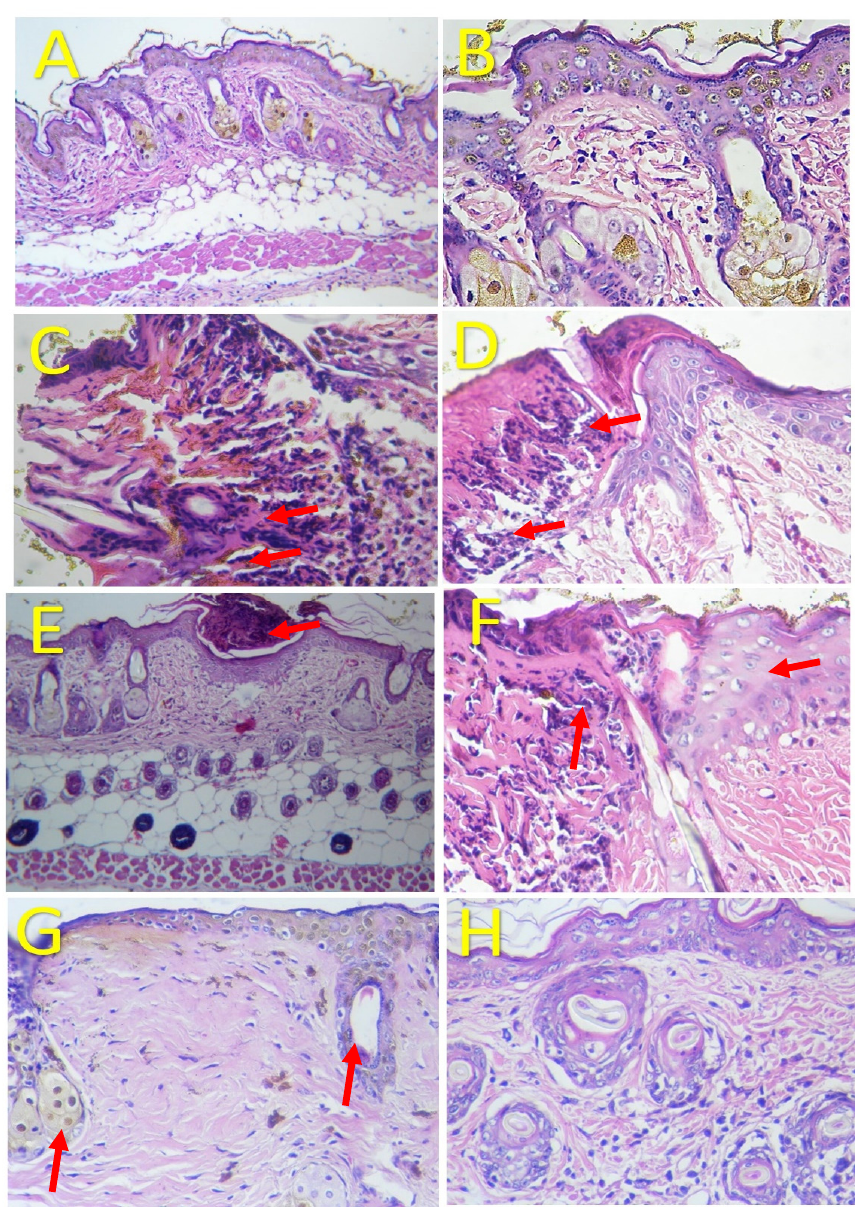
Figure 3 . Histological analysis of skin tissue healing. Photomicrographs of ( A – H ): Hematoxylin and Eosin (H&E) staining with 10× and 40× magnification. A-B : (Control group). The epithelial surface, the connective tissue underneath, the hair follicles, and the sebaceous glands are unaltered. C . (Control group; 24 h): A loss of epithelium and the infiltration of polymorphonucleate leuko- cytes are clear. The epithelium also presents bleeding and fibrinoid exudate. D . (Control group; 7 days): This shows an inflammatory reaction to polymorphonuclear leukocytes. E . (Control group; 10 days): A small superficial abscess can be observed in the outermost layer of the epidermis. F . (Latex group; 24 h): This reveals a dense inflammatory reaction and the presence of polymorpho- nuclear leukocytes. However, the epithelium is better preserved, with keratinocytes present below the superficial infiltrate. G . (Latex group; 7 days): An area with fewer insertions (hairs and seba- ceous glands), with more collagen fibers ranging from dense to thick. H . (Control group; 10 days): Here, the skin is normal.